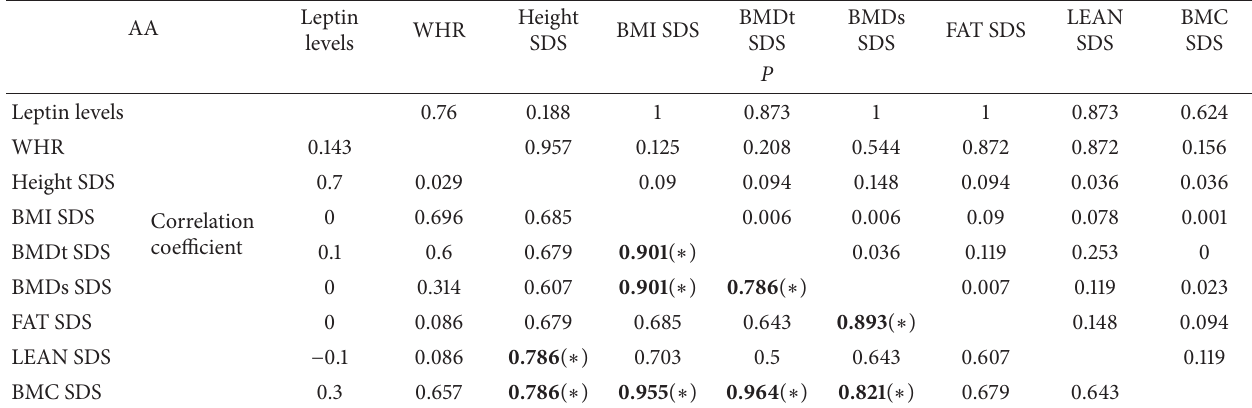
Table 7: Correlation between anthropometric and densitometric parameters in the group with LEPR gene genotype AA. AA